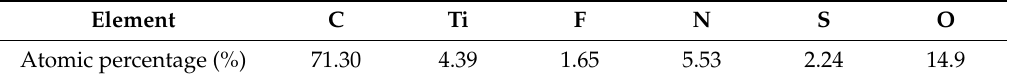
Table 1. Atomic percentages of MXene-SO3H/RhB composite films from XPS measurement.